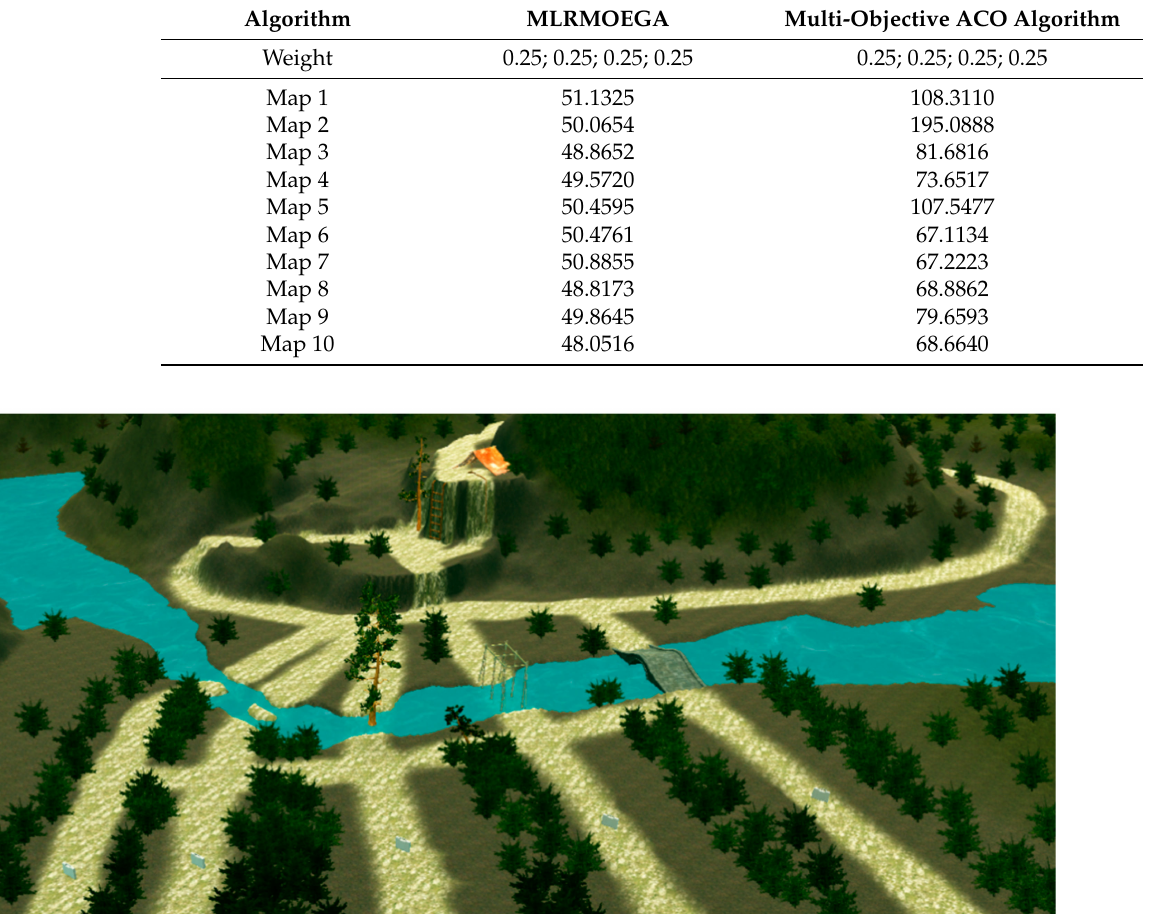
Table 12. The values of synthetic objective function compared with multi-objective ACO algorithm.